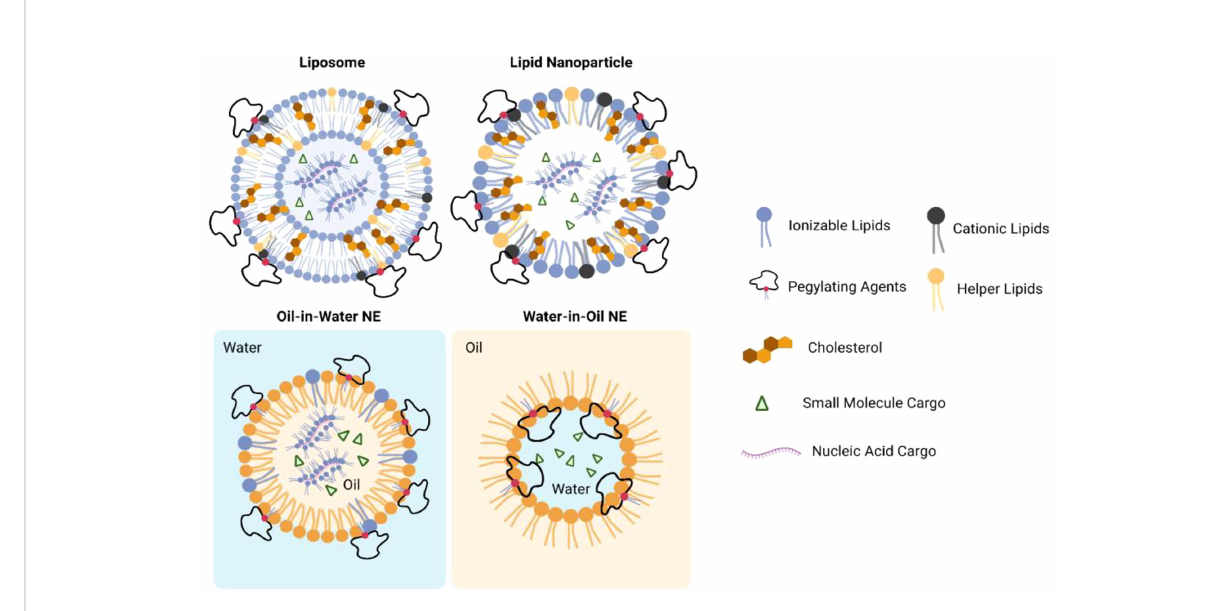
FIGURE 2 Structures of lipid-based nanoparticles when encapsulating small molecule or nuclei acid